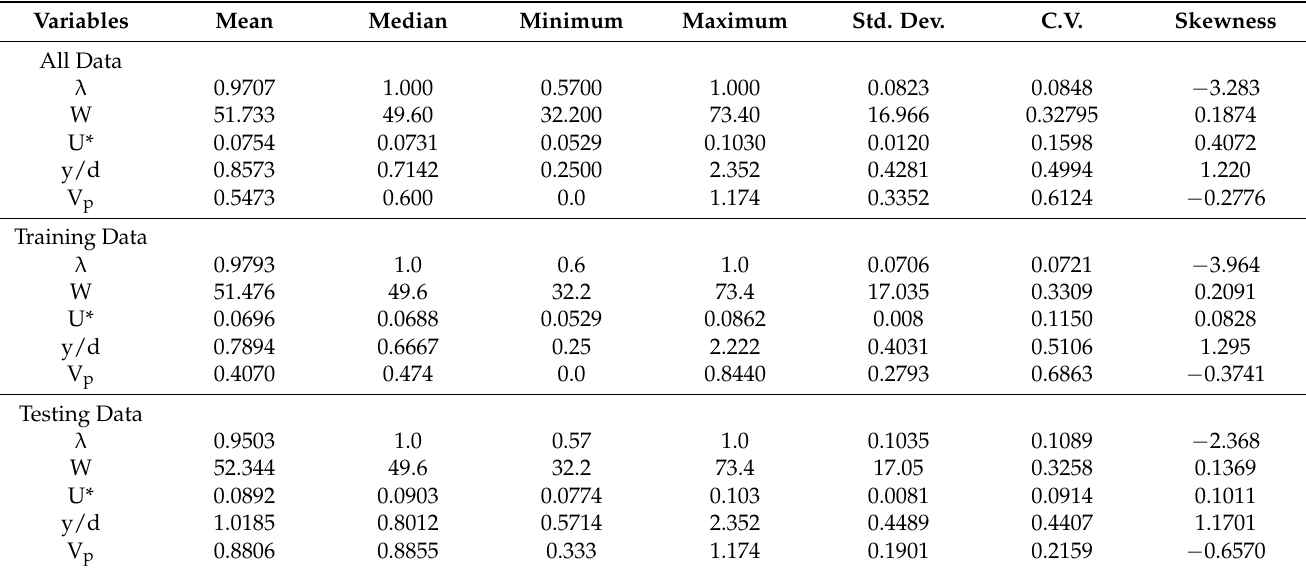
Figure 4. Plots of the dependent variable V p (m/s) and input variable: ( a ) EATBAR, ( b ) weight (gm), ( c ) shear velocity (m/s), ( d ) relative depth. Table 1. Statistical analysis of dependent (V p ) and independent variables ( λ , W, U*, and